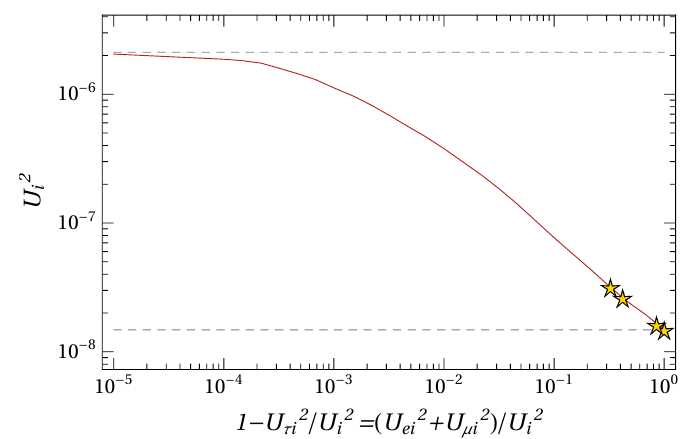
Figure 8. Dependence of the NA62 sensitivity on U 2 the benchmark scenarios A){D), the horizontal lines mark the extreme scenarios with U 2 and U 2 = U 2 i (cid:28)i